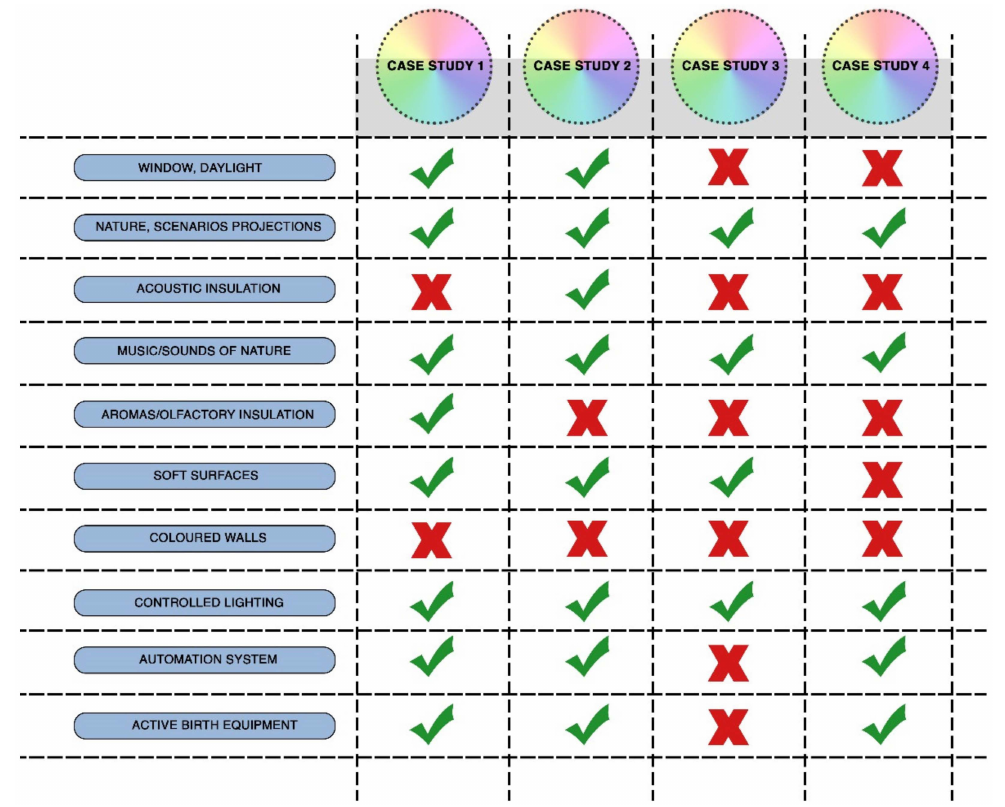
Figure 5. Diagram showing the presence of birth sensory solutions in case